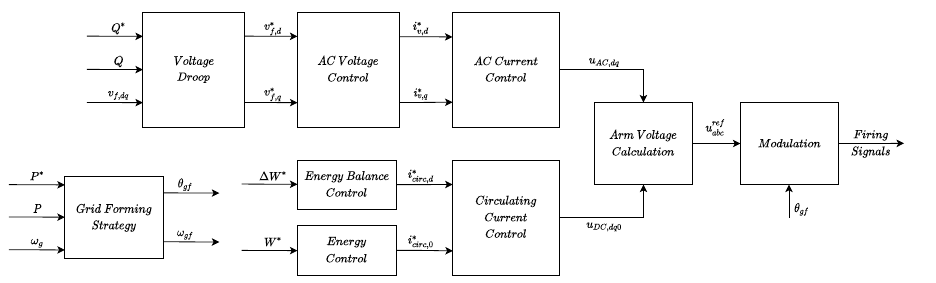
Figure 4. Block diagram of an MMC-based GFM